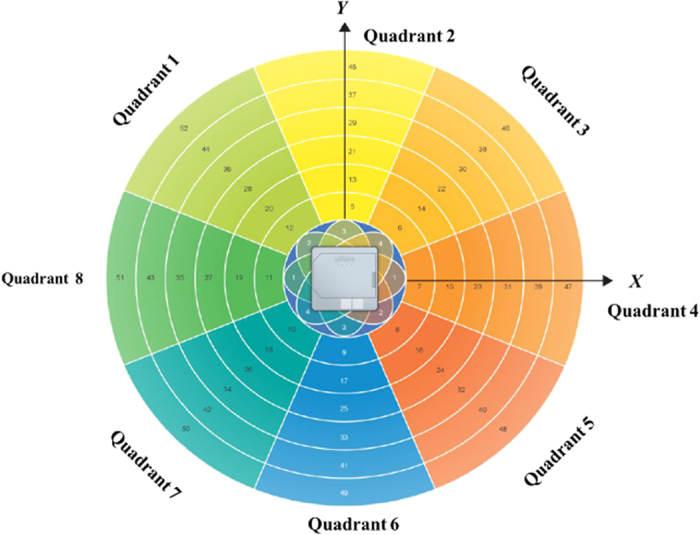
Phased array antenna effect chart23.